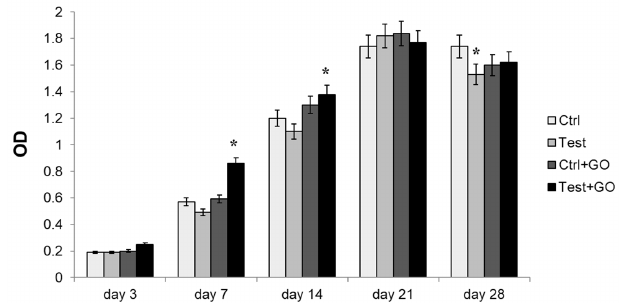
Figure 5. SEM images of DPSCs cultured on control, test, control + GO, and test + GO discs for 3, 14, and 28 days. Magnification 2000×.